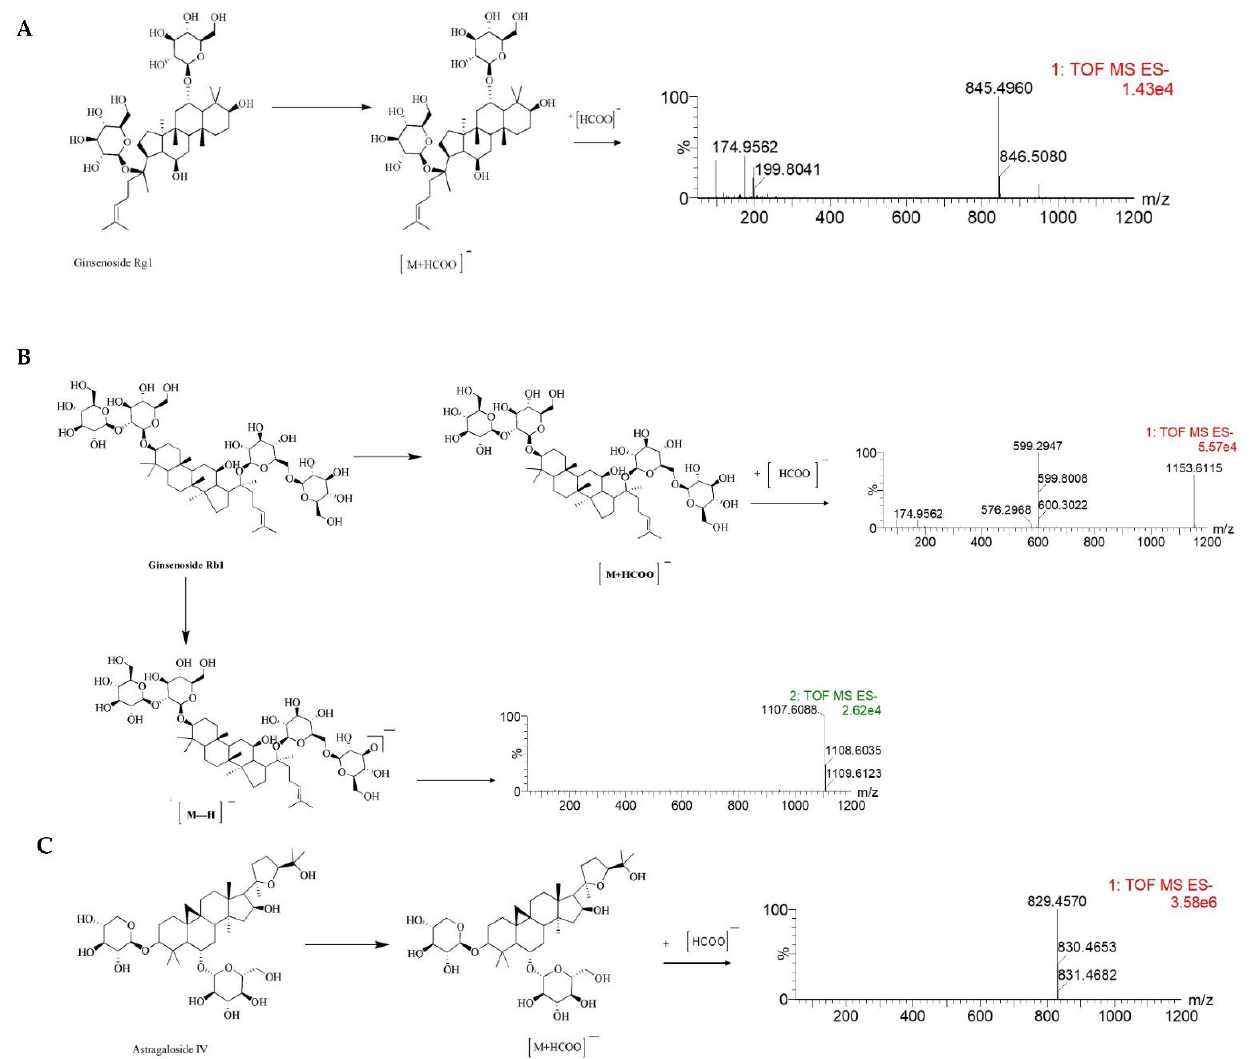
Figure 2. The MS/MS spectrum and possible fragmentation pathway of Ginsenoside Rg1 ( A ), Ginsenoside Rb1 ( B ), and Astragaloside IV ( C ).